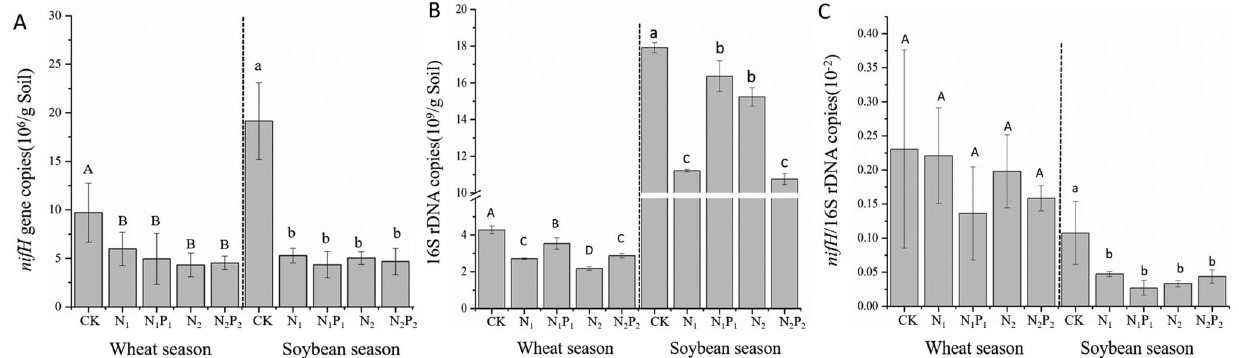
Figure 1. Absolute abundances of the nif H gene and 16S rDNA in two crop seasons. ( A ) The absolute abundance of the nif H gene. ( B ) The absolute abundance of 16S rDNA; ( C ) The ratio of nitrogen-fixing microorganisms to